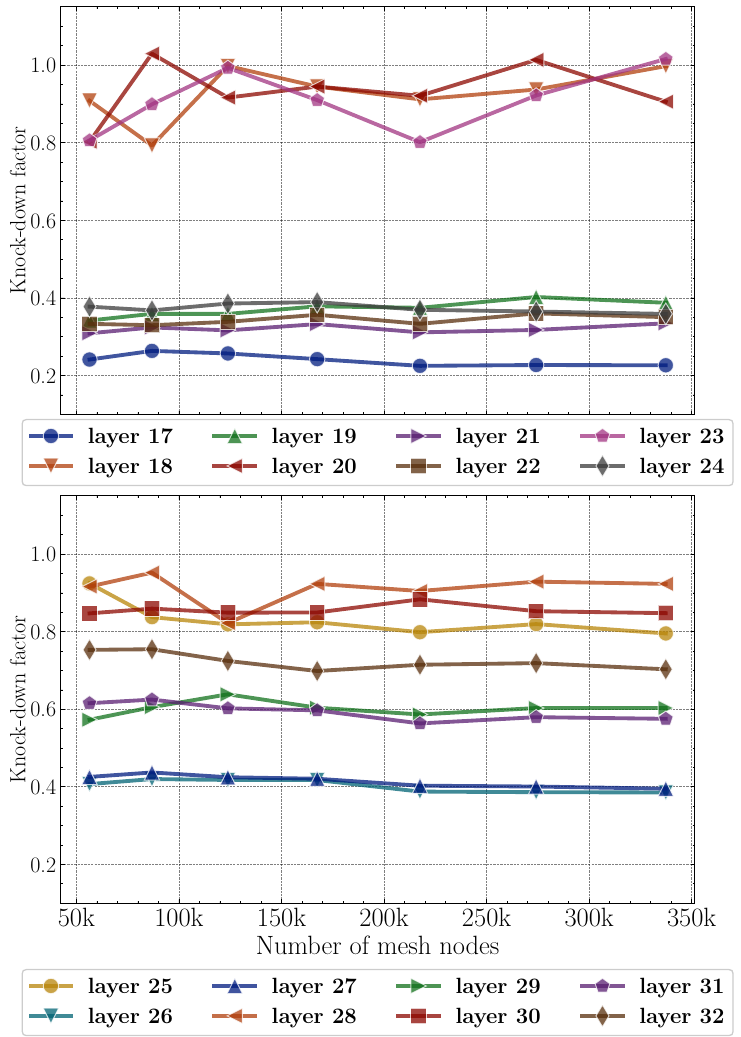
Figure 9. Convergence of KDF according to mesh refinement in the